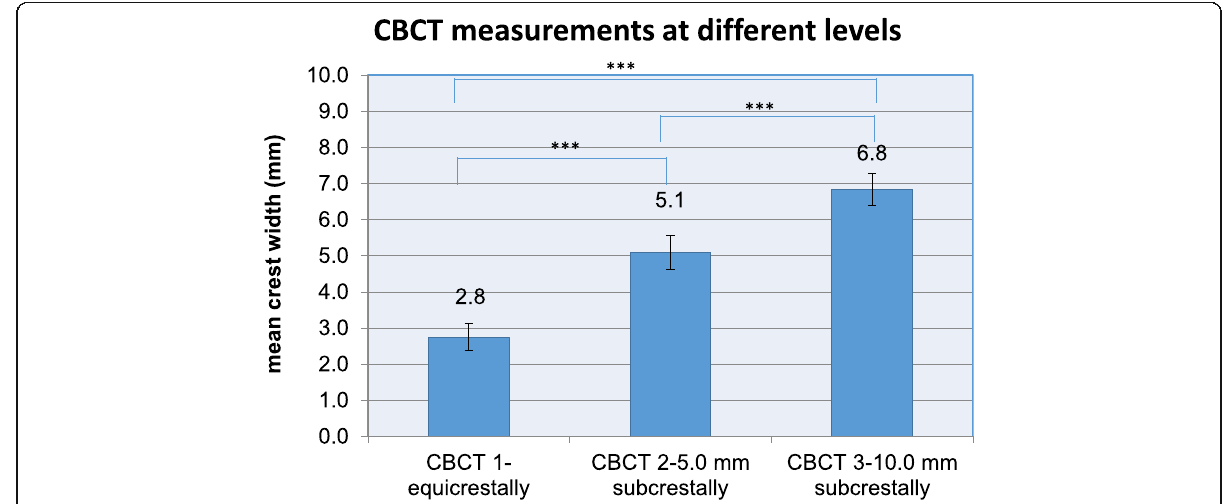
Fig. 4 Pre-operative CBCT measurements at three different levels of the alveolar crest displaying significant differences in ridge